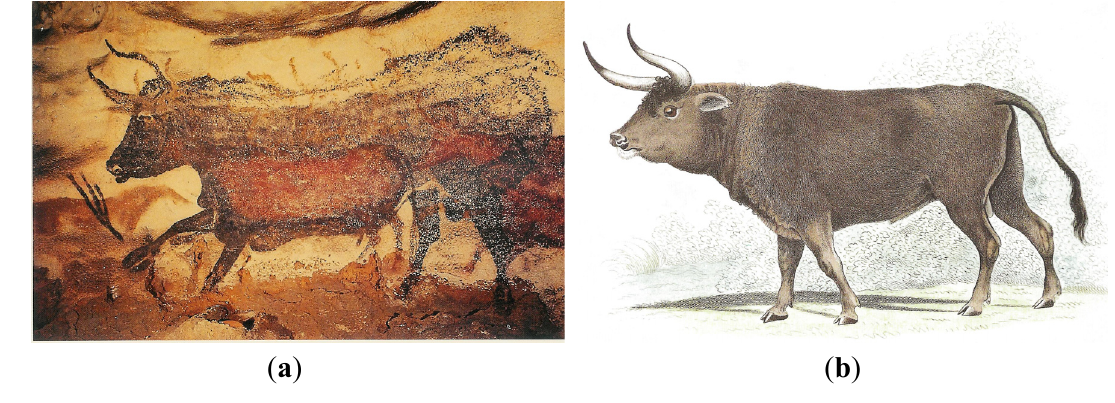
Figure 3. Contemporary pictures of the aurochs: ( a ) Painting in the Lascaux caves; ( b ) the Augsburg aurochs , woodcut 1826 after a lost 16th century painting [11]; ( c ) Rock engraving of African cattle showing a captured aurochs bull (Messak, Lybia, 6000 BP) [10]; and ( d ) 16th century picture by Philip Galle (Museum Boymans Van Beuningen, Rotterdam, courtesy Rolf Zeegers). Two Latin hexameters in the caption (not shown) suggest how the aurochs became extinct, in translation: Thus everywhere, with spears, light arrows and swords, in pitfalls they drove the aurochs, strong with horns